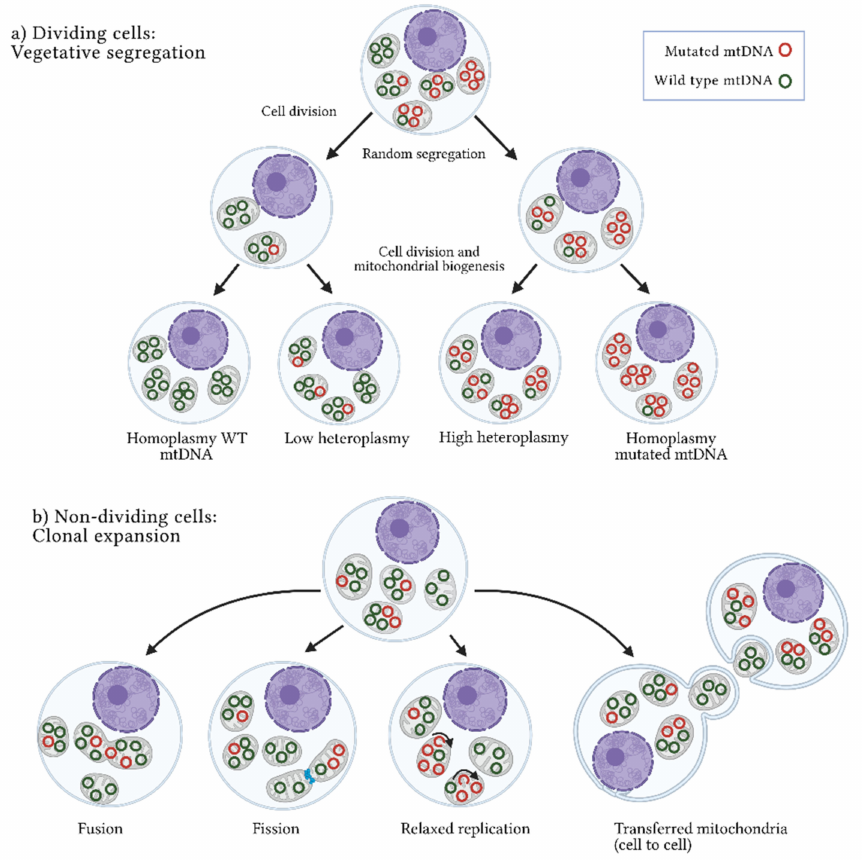
Figure 1. Heteroplasmy origin. Two mechanisms have been suggested to explain the origin and maintenance of the coexistence of wild-type and mutated mtDNA or heteroplasmy: ( a ) Vegetative segregation. In dividing cells, mitochondria are randomly distributed among daughter cells, resulting in different proportions of mutated mtDNA molecules between them. ( b ) Clonal expansion. In non-dividing cells, heteroplasmy is maintained through dynamic mitochondrial processes, such as fusion (union) or fission (separation) of mitochondria, relaxed replication (mtDNA replication independent of cell division) and intercellular mitochondrial transference. WT: wild-type; mtDNA: mitochondrial DNA molecules. Figure artwork created with